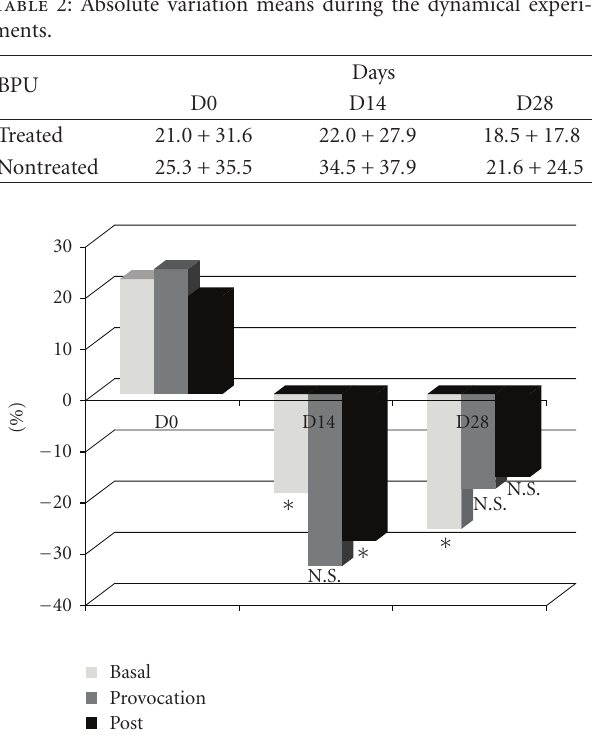
Figure 1: Di ff erences in each evaluation period expressed as the variation against the control ( ∗ P < . 05; NS: Nonsignificant: Comparison against D0). Table 3: Variation related to D0 of the morfometric assessment for each evaluation area (cm) ( ∗ P < . 05; NS: Non significant: Comparison against control variations).